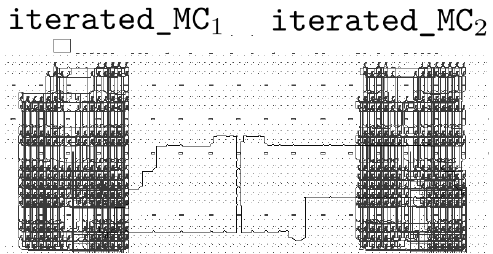
Figure 10: The pipe is placed between the iterated_MC 1 and iterated_MC 2 modules.